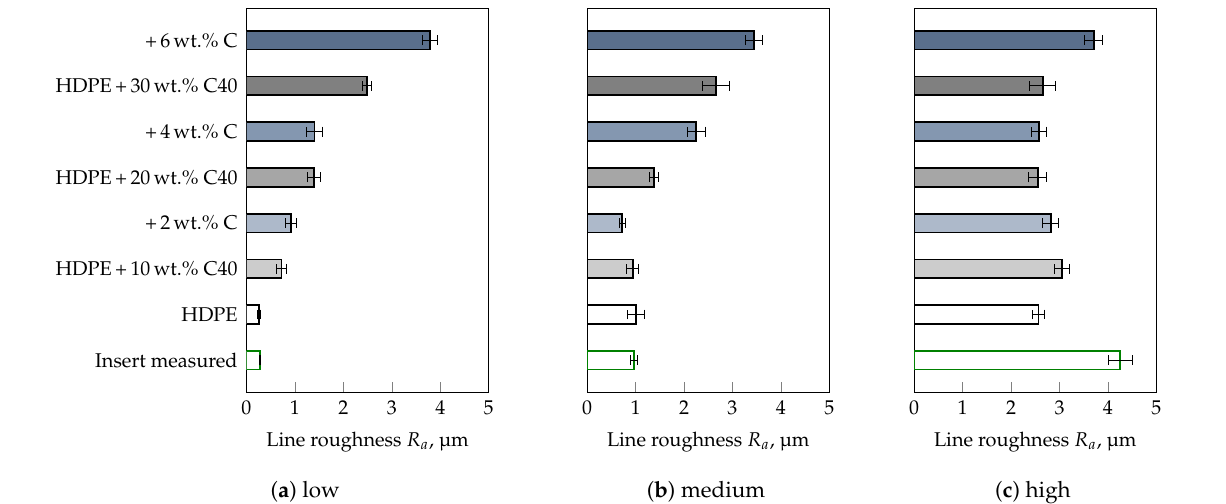
Figure 8. Influence of filler CalPlex 40 (C40, D 50 = 16–25 µ m), and compatibilizer (C) content on the impression quality. Deployed insert with a target line roughness of ( a ) 0.2 µ m (low), ( b ) 0.8 µ m (medium), and ( c ) 3.2 µ m (high).